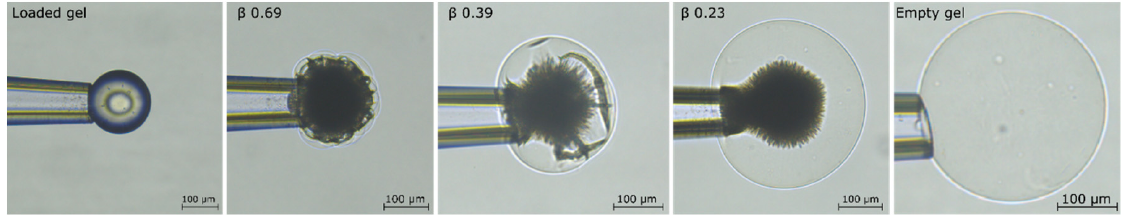
Figure 6. AMT distribution in polyacrylate microgels at different binding ratios in a solution of 155 mM ionic strength. Loaded gel represents overnight equilibration of the gel in 0.7 mM AMT solution of 10 mM ionic strength. Empty gel represents the gel in 155 mM phosphate buffer solution after AMT releases.